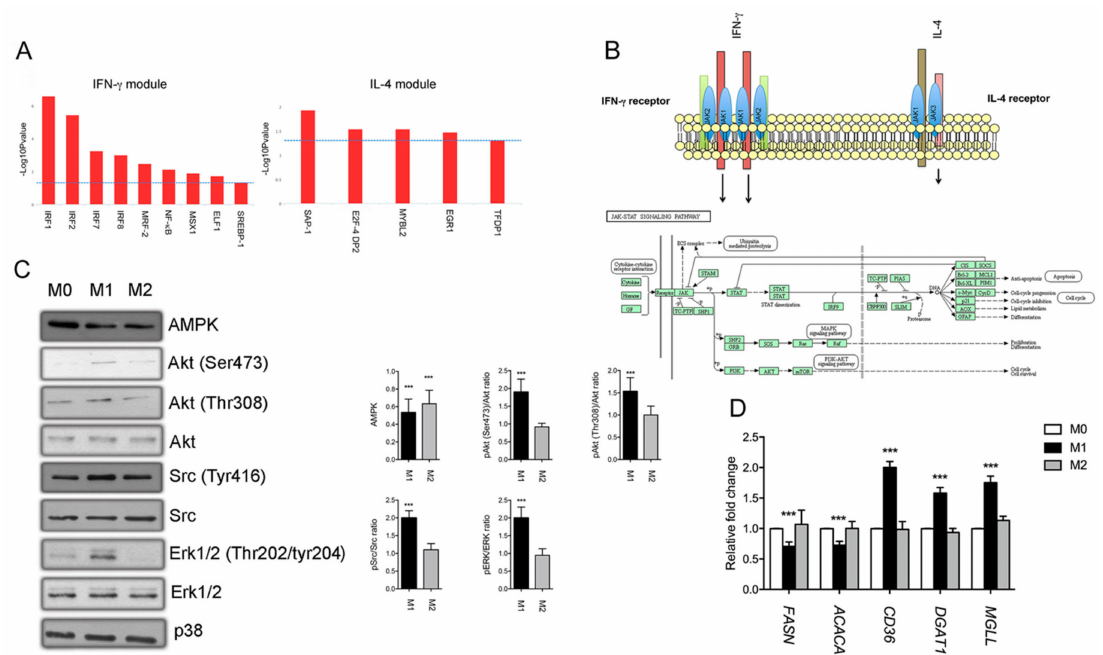
Figure 4. Transcriptional regulation and regulatory signaling pathways activated after exposure of CHME-5 with IFN- γ and IL-4. ( A ) Transcriptional factor binding site (TFBS) over-representation analysis result by InnateDB performed on IFN- γ and IL-4 specific protein clusters identified by ANOVA and represented in Figure 4. ( B ) Schematic representation of IFN- γ and IL-4 receptors and key signaling pathways involved. ( C ) Western blot analysis of Erk1 / 2, Erk1 / 2 (Thr202 / tyr204), Src, Src (Tyr416), Akt, Akt (Thr308), Akt (Ser473), AMPK in M0, M1, and M2 cells. P38 was used as loading control. The graph shows the relative densitometric quantification of band intensities measured using ImageJ analysis software. Values are means ± S.D. of three independent experiments. p value *** < 0.001 compared to M0 cells. ( D ) Di ff erential expression of enzymes involved in lipid metabolism between M0 and M1 cells. FASN , ACACA , CD36 , DGAT1 , and MGLL mRNA levels in M0, M1, and M2 cells. Values are means ± S.D. of three independent experiments. p -Value *** < 0.001 calculated by